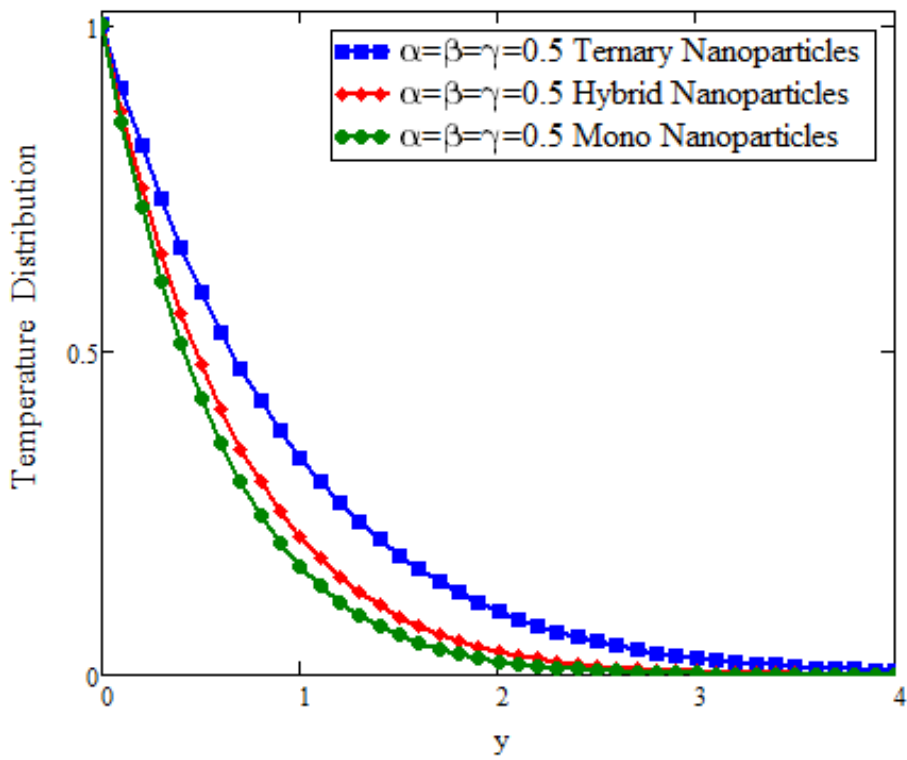
Figure 2. Comparison of temperature assessment across y as α = 0.5, β = 0.5, and γ = 0.5 when t = 0.04, Sc = 1.5, and Pr = 21.